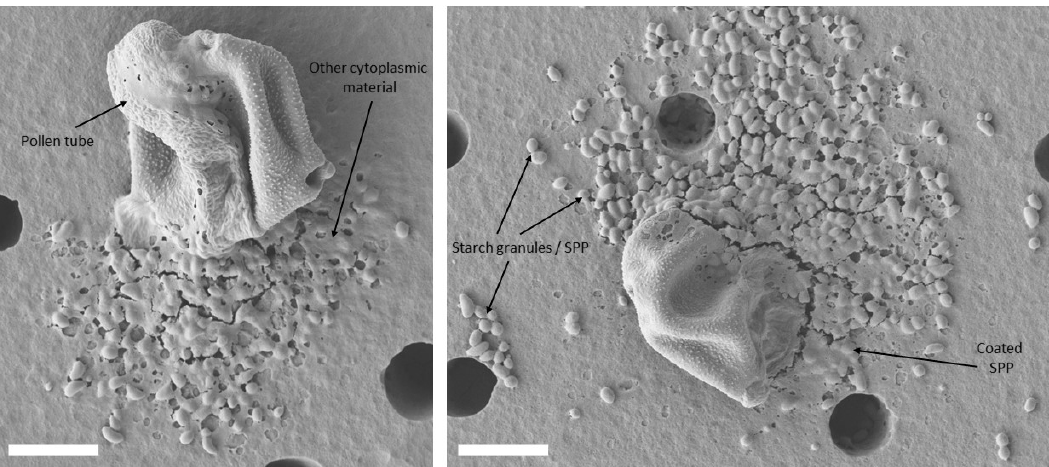
Figure 4. Germinated and ruptured pollen grains. Freshly harvested birch pollen grains were exposed to high relative humidity. Pollen grains were deposited on a polycarbonate nuclepore filter (pore size: 8µm) within an inline filter holder, and humid air (95% relative humidity) was sucked through for 8h. This process can only be observed with fresh pollen grains. Commercial pollen grains remained intact after the same treatment. White scale bar is 10µm.